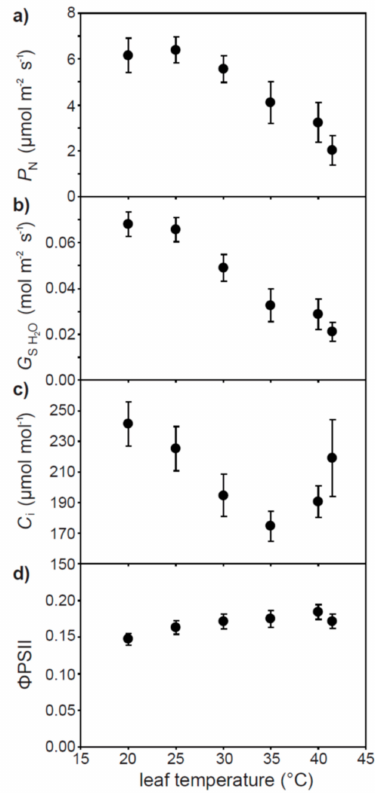
Figure 5. Response of photosynthesis ( P N ) ( a ), stomatal conductance ( G s H2O ) ( b ), intercellular sub-stomatal air-space [CO 2 ] ( C i ) ( c ), and the actual quantum efficiency of PSII under steady state conditions in the light ( Φ PSII) ( d ) to an instantaneous increase in leaf temperature over a range of 20 to 41.5 ◦ C of well-watered olive plants. Error bars indicate one standard deviation either side of the